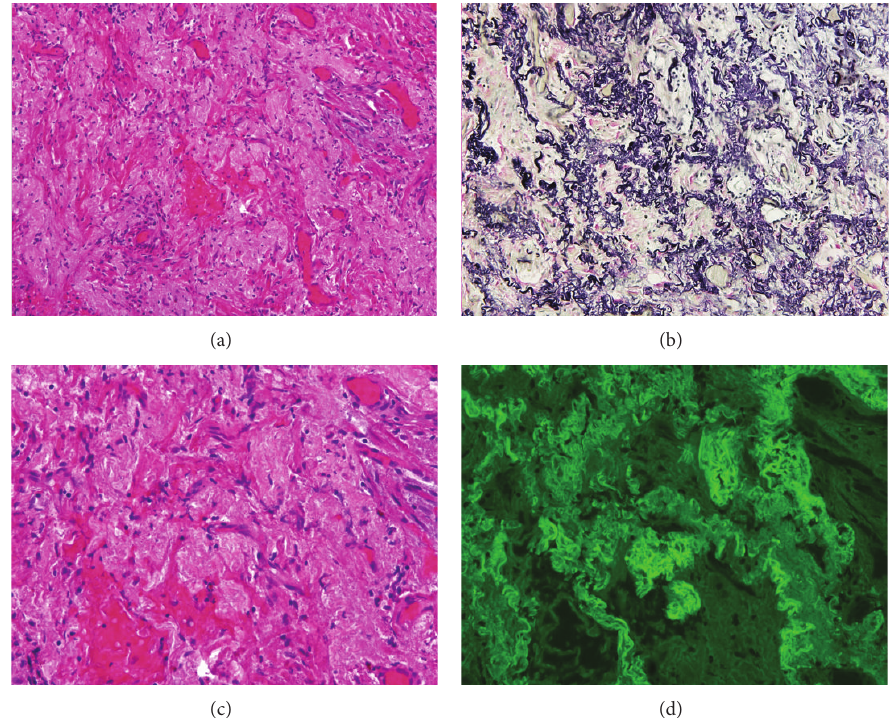
Figure 9: Surgical lung biopsy of the right upper lobe of Case 2. (a) The alveolar structures are completely obliterated due to accumulation of elastotic material in the wall. HE 100x. (b) At higher magnification, the presence of a very small lymphocytic infiltration is showed. (c) Using the Van Gieson stain, the elastotic content of the wall is observed and the alveolar lumen is replaced by connective tissue. (d) Using autofluorescence, the presence of numerous elastic fibbers is observed in the same field of Figure 9(b).